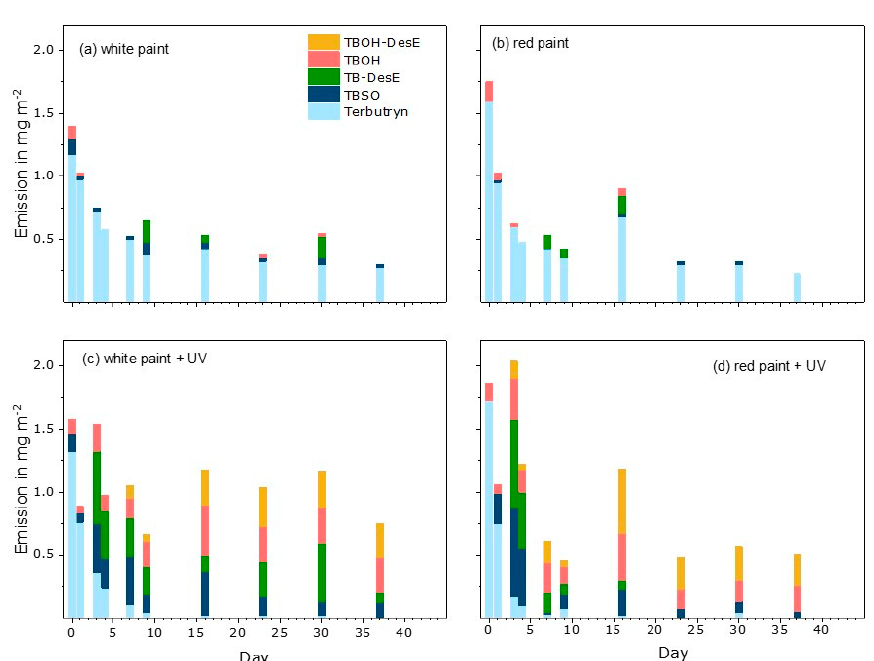
Figure 3. Emission of terbutryn and transformation products during immersion cycles. Upper row: test specimens were kept in a dark room at 21 ± 2 °C and 60 ± 5% relative humidity between the immersion cycles; lower row: test specimens were exposed to UV radiation at 40 °C between the immersion cycles. Each column represents a single experiment. The first data points for both experiments on either white or red paint layers can be considered independent repetitions and indicate the variability of results between test specimens.